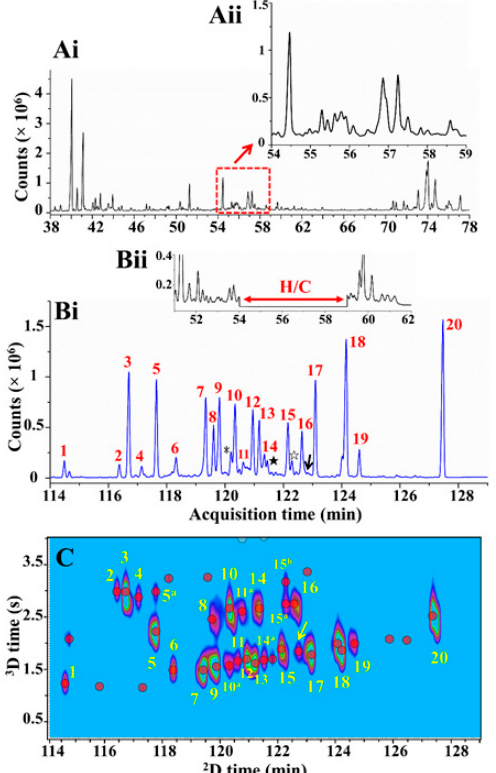
Figure 7. Integrated MDGC-GC × GC analysis of Agarwood ( A. malaccensis ) oxygenated terpenes. GC-FID 1 D chromatogram ( Ai ) and the expansion of the target region ( Aii ) to be heart-cut. MDGC chromatograms showing the heart-cut (H / C) region in the 2 D TOFMS detection ( Bi ) and 1 D FID detection ( Bii ). GC × GC-TOFMS chromatogram ( C ) showing the comprehensive separation of the target region. Source: adapted with permission from Yan et al. [12].